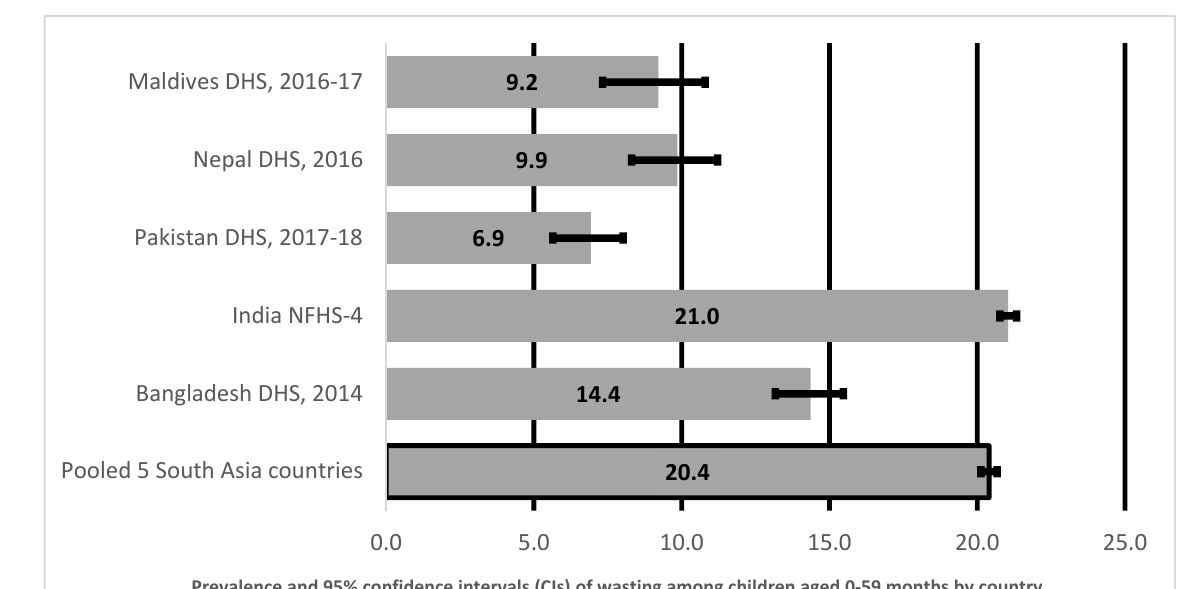
Figure 2. Prevalence and 95% confidence intervals of wasting in children aged 24–59 months in South Asia.